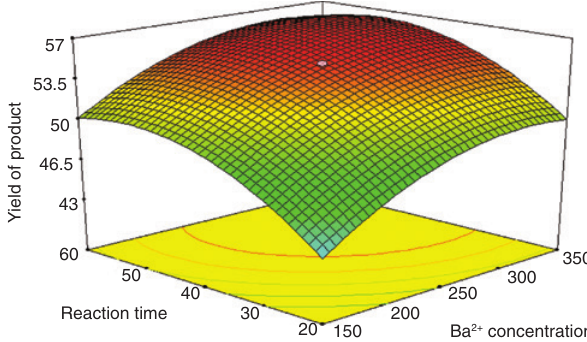
Figure 4: Response surface for effect of Ba 2 + concentration and reaction time on yield.